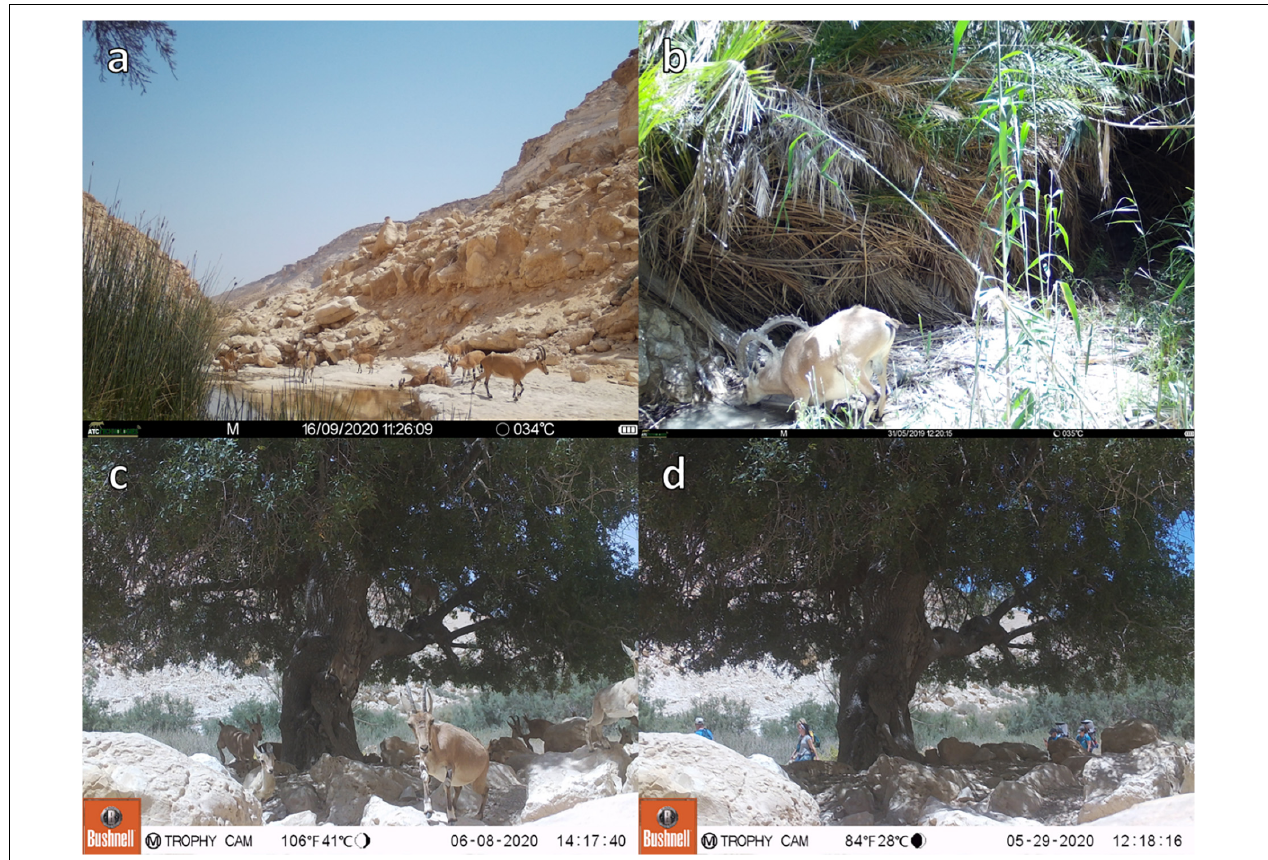
FIGURE 2 | Camera footage from the camera traps used in the study: (a) in front of the water pool in Ein-Avdat. (b) In front of the water pool in Ein-Shaviv, (c,d) in front of the Pistacia atlantica tree in Ein